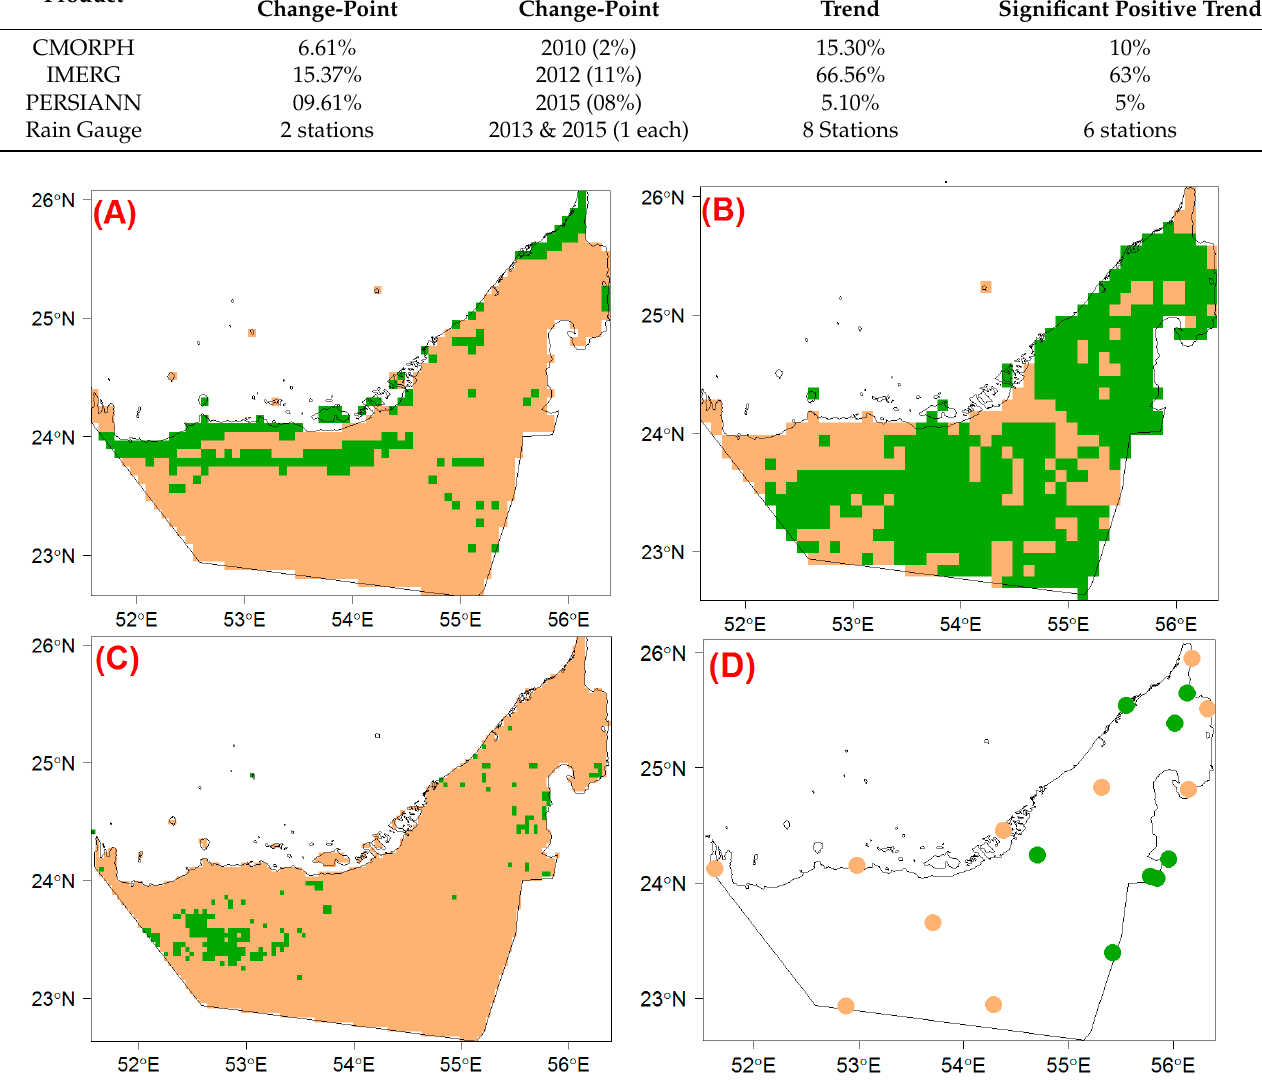
Figure 10. Locations with a significant (green color) and not-significant (brown color) trend according to the Correlated Seasonal Mann–Kendall test for ( A ) CMORPH, ( B ) IMERG, ( C ) PERSIANN, and ( D ) rain gauges.